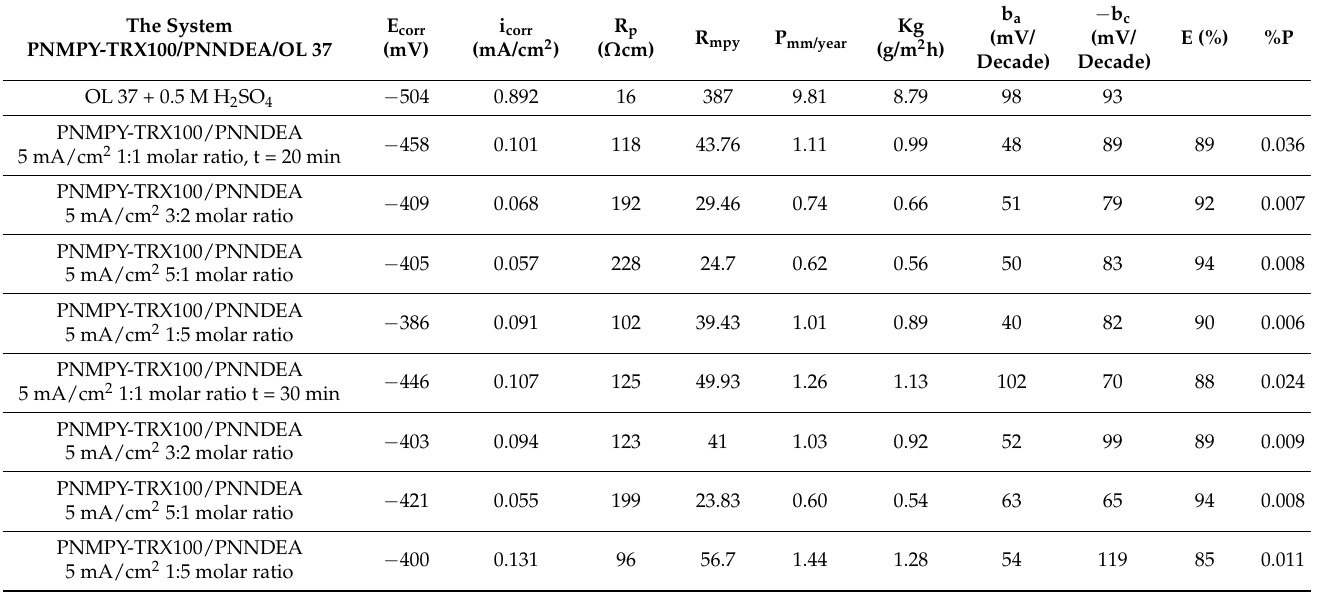
Table 2. Kinetic Corrosion Parameters of Coated and Uncoated OL37 Electrode in 0.5 M H 2 SO 4 Solution at 25 ◦ C. The System PNMPY-TRX100/PNNDEA/OL